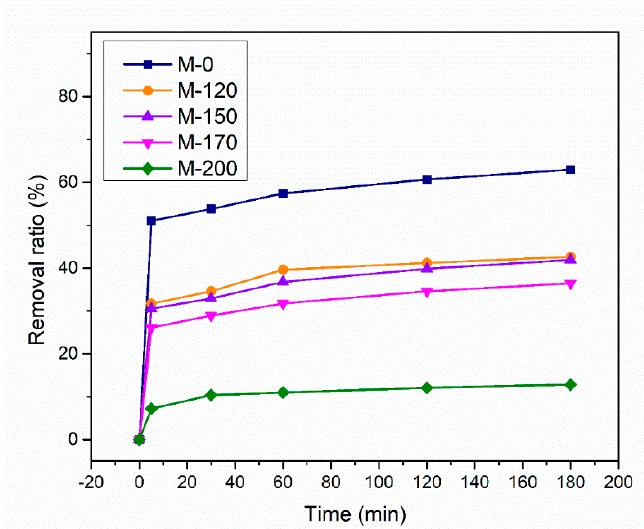
Figure 4. The X-3B adsorption of all samples. Experimental conditions: (X-3B) = 100 mg L − 1 , (PS) = 15 mmol L − 1 , catalyst dosage = 0.1 g L − 1 , T = 25 °C.